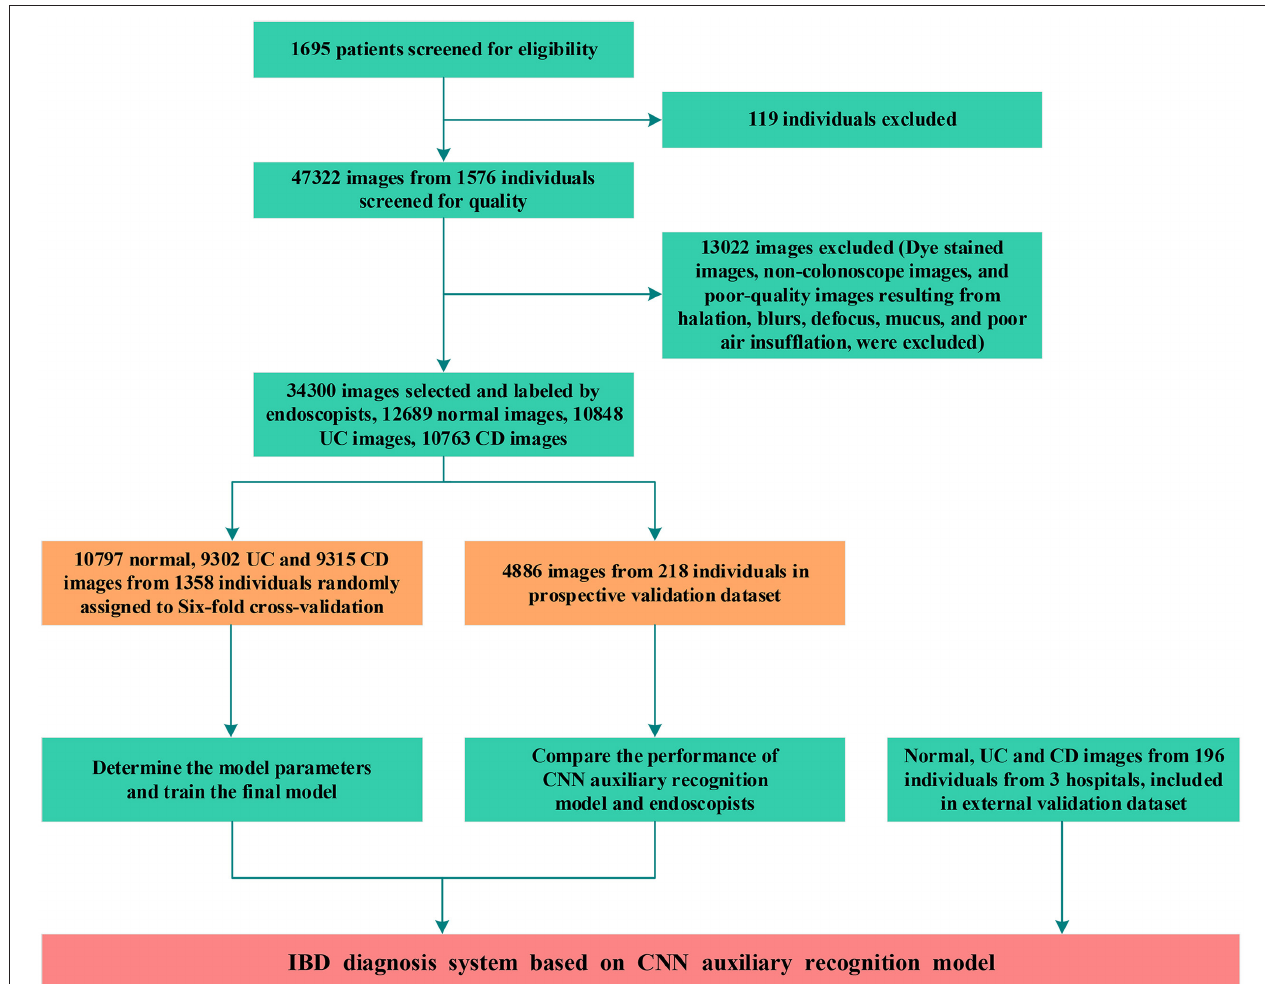
FIGURE 2 | Workflow diagram of the development and evaluation of the deep learning model. UC, ulcerative colitis; CD, Crohn’s disease; CNN, convolutional neural network.